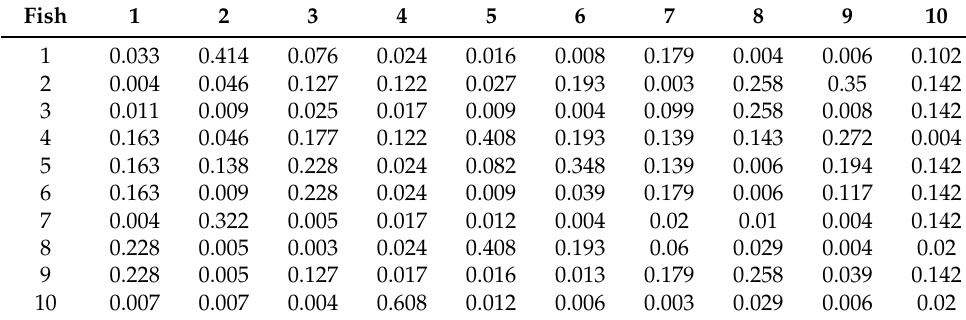
Table A19. Normalization matrix of fish.